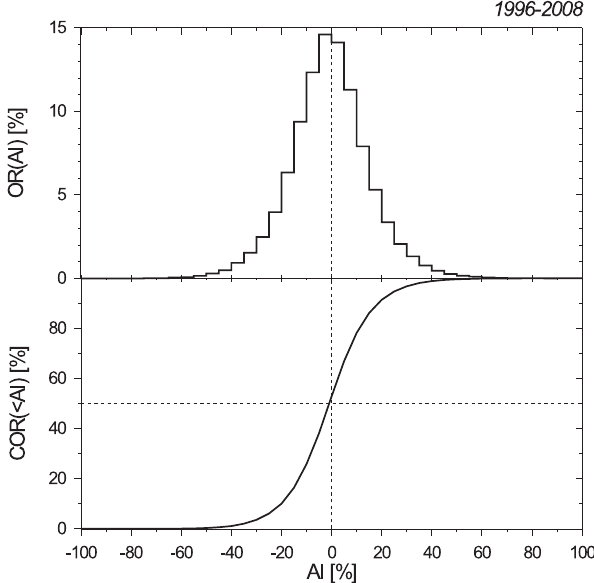
Fig. 4. Histogram of hourly AI values derived from occurrence rates OR(AI) of width 5% for the interval between 1996 and 2008 (upper part) and the corresponding cumulative occurrence rate COR( < AI) (lower